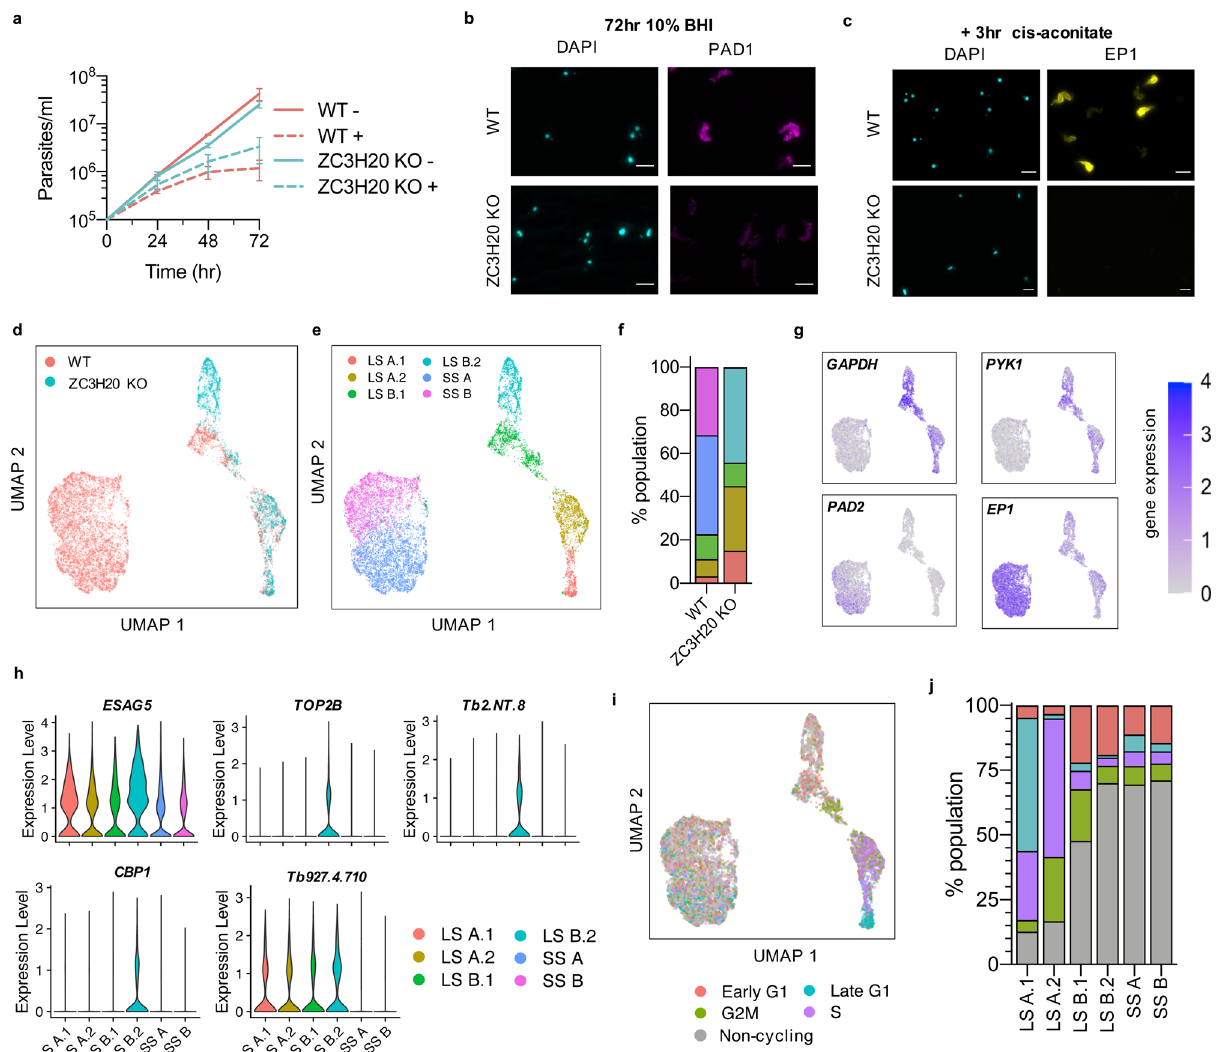
Fig. 5 scRNA-seq analysis of differentiation incompetent ZC3H20 KO T. brucei parasites. a Cumulative growth of WT (red) and ZC3H20 KO (blue) T. brucei in culture with (dashed line) and without (solid line) 10% BHI broth. y -axis shows parasites per ml on a log10 scale. Data are presented as the mean + / − SD of three independent replicates. b Staining of WT and ZC3H20 KO parasites with anti-PAD1 antibody after 72 h incubation with 10% BHI broth. Scale, 5 μ m. Two biological replicates were performed. c EP1 staining of WT and ZC3H20 KO after 3 h treatment with cis -aconitate to induce differentiation of 72 h BHI + samples into procyclic forms. Scale, 5 μ m. Two biological replicates were performed. d UMAP plot of integrated WT cells (red) and ZC3H20 KO cells (blue) coloured by cell type. e UMAP plot of integrated WT and ZC3H20 KO cells coloured by cluster identi fi cation (long slender (SL) A.1 in red, LS A.2 in yellow, LS B.1 in green, LS B.2 in aqua, shorty stumpy (SS) A in dark blue and SS B in purple. f Proportion of cells in each cluster identi fi ed in integrated WT and ZC3H20 KO cells. Colours as in ( e ). g UMAP of WT and ZC3H20 KO parasites coloured by transcript count of marker genes, as in Fig. 1b. h Violin plots of the top long slender B.2 marker gene expression in each cluster identi fi ed in ( e ). i UMAP of integrated WT and ZC3H20 KO cells coloured by cell-cycle phase (Early G1 in red, Late G1 in blue, S in purple, G2M in green and non-cycling in grey). j Percentage of cells in each cell cycle phase, or non-cycling, divided by cluster. Colours as in ( i ZC3H20 itself. We fi rst tested the effect of 10% BHI broth on return to growth after 48 h of recovery (Fig. S4). In addition, we ZC3H20 null T. brucei parasites (ZC3H20 KO) 27 (Fig. 5a – c). In tested the ability of WT and ZC3H20 KO parasites exposed to the presence of 10% BHI broth, replication of ZC3H20 KO BHI for 72 h to differentiate into procyclic cells. Consistent with parasites slowed after 72 h of culture (Fig. 5a). In addition, the their inability to generate stumpy forms, after 3 h of cis -aconitate ZC3H20 KO parasites failed to express the stumpy marker pro- treatment and incubation at 27 °C, none of ZC3H20 KO parasites tein PAD1 (Fig. 5b) and did not change in cell width, indicating expressed EP1 procyclin, in contrast with 84.34% of WT parasites they did not progress towards a typical stumpy morphology (mean of two biological replicate experiments), con fi rming (Fig. S5). To assess if ZC3H20 KO parasites are irreversibly ZC3H20 KO T. brucei fail to differentiate into functional stumpy growth arrested in response to BHI, ZC3H20 KO and the parental cells when exposed to BHI broth (Fig. 5c). cell line were treated with fresh BHI for 48 h before washing the ZC3H20 KO parasites were next cultured in 10% BHI for 0, 24, parasites and returning them to BHI-free media. The growth of 48 or 72 h and subjected to scRNA-seq, as for WT samples. After ZC3H20 KO parasites recovered rapidly once returned to BHI- quality control fi ltering, 2295 cells (median 1051 genes per cell) free media, whereas the wild-type parasites showed a delayed remained and were integrated with the WT cells before